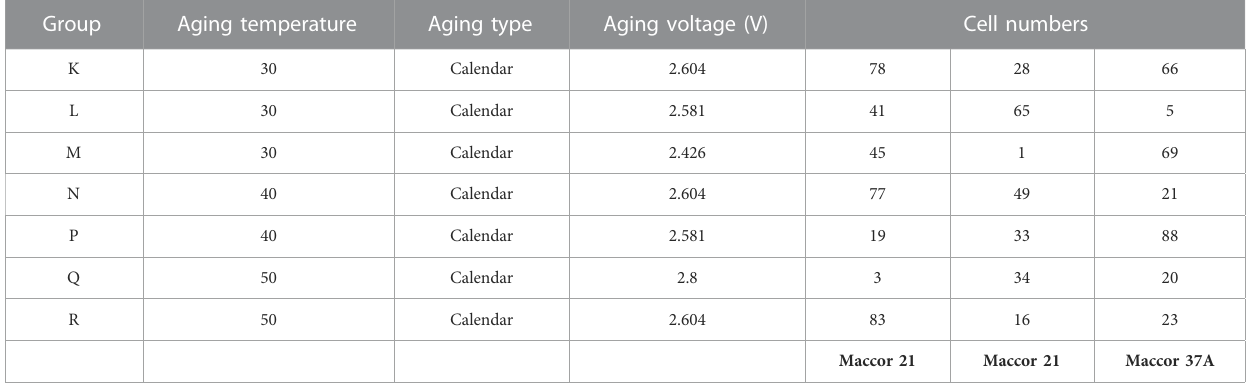
TABLE 2 (B) BTMS calendar-life testing of LMO/LTO cells.